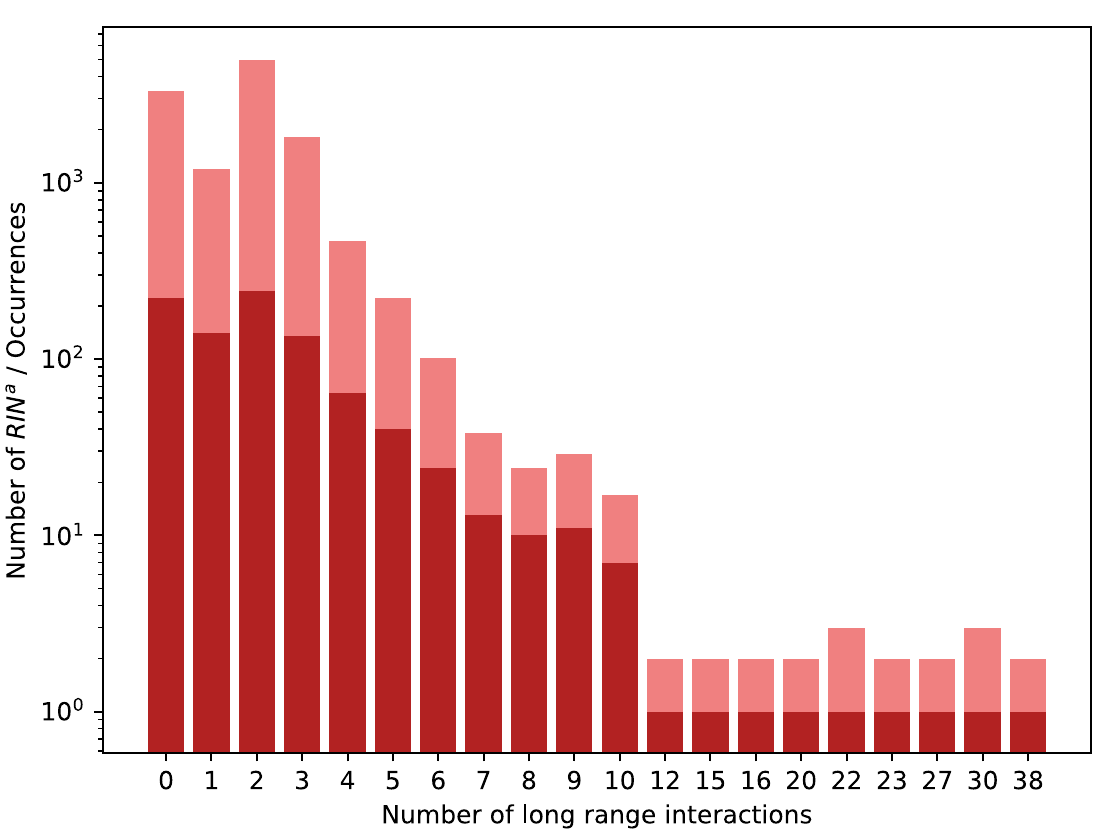
Fig 9. Distribution of RIN a in Dataset 2.92. Numbers of distinct RIN a s numbers of long range interactions they contain in Dataset 2.92.